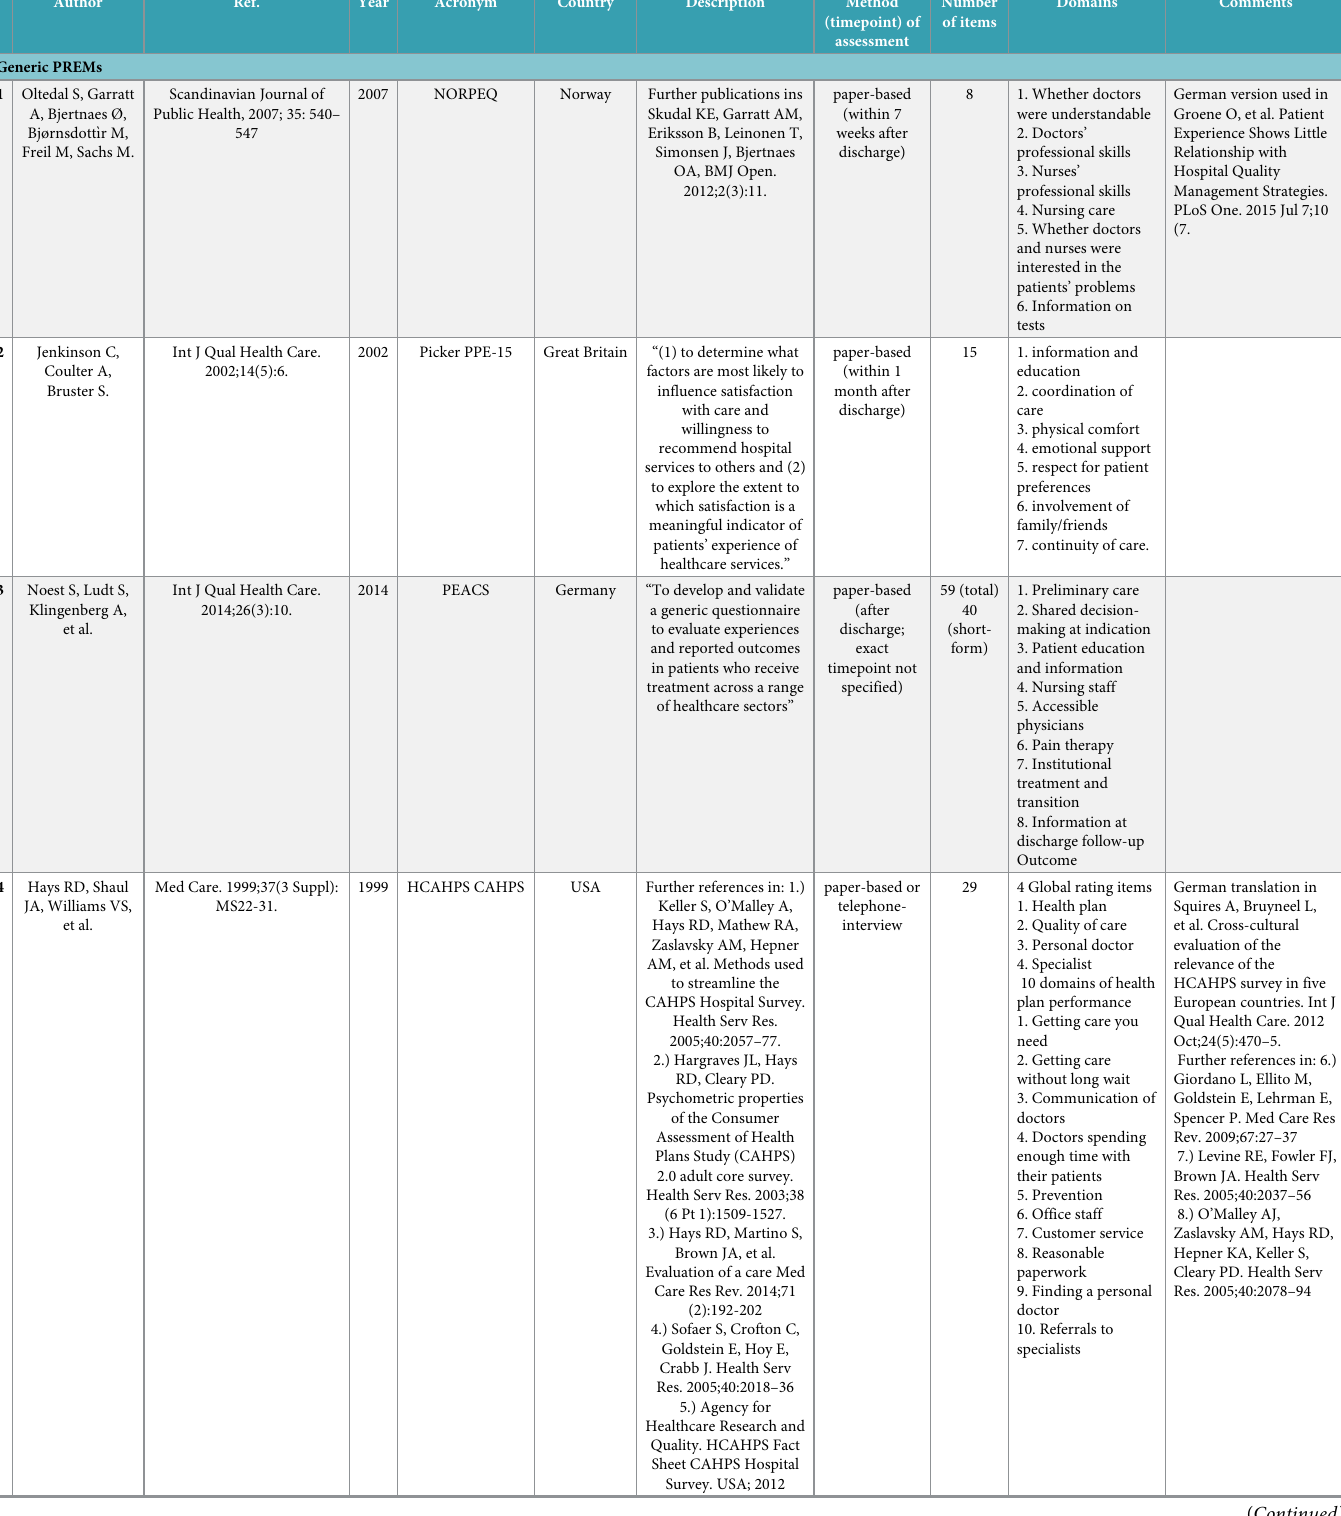
Table 2. Study characteristics of German-language Patient-Reported Experience Measures